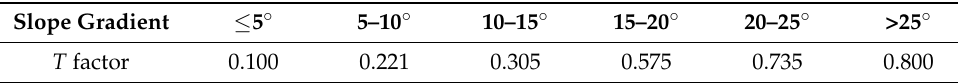
Table 2. T factor under different slope gradient.